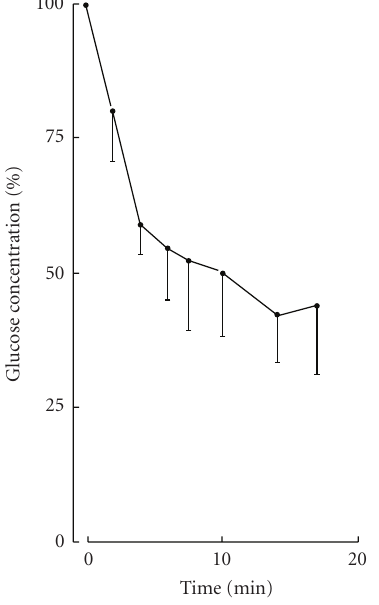
Figure 2: Time course for the changes in glucose concentration during successive samplings of stimulated saliva in 5 subjects. Geometric mean values ( ± SEM) refer to results expressed in percent of paired first